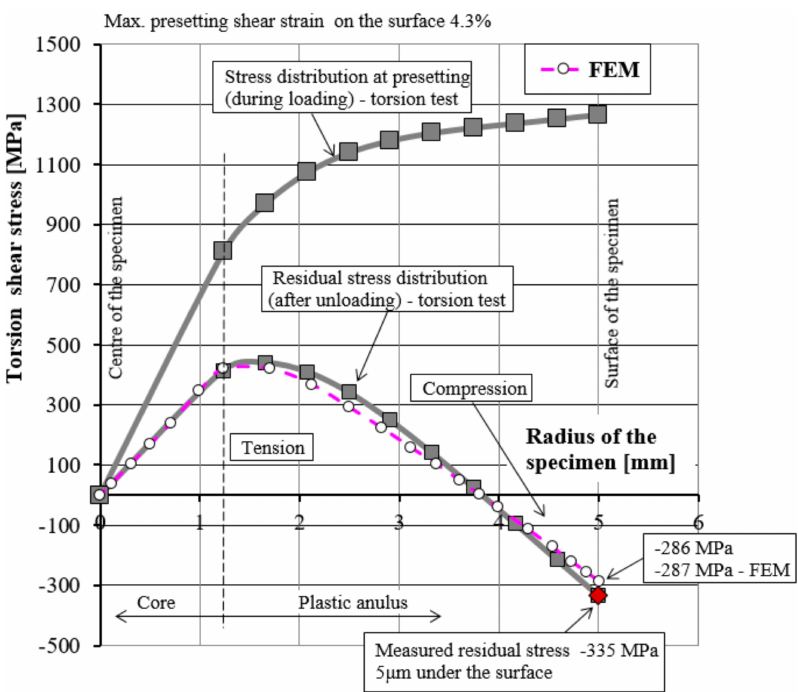
Figure 9. Shear stress distribution over cross section of the specimen after the shear presetting strain of 4.3%, determined with an analytical and FEM1214 calculation and comparison between the calculated stress value at surface of the specimen and the measured one